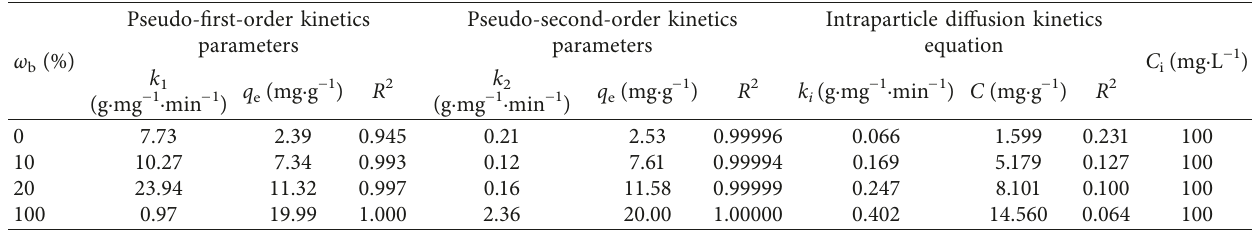
Table 4: Values of pseudo-second-order kinetics parameters.